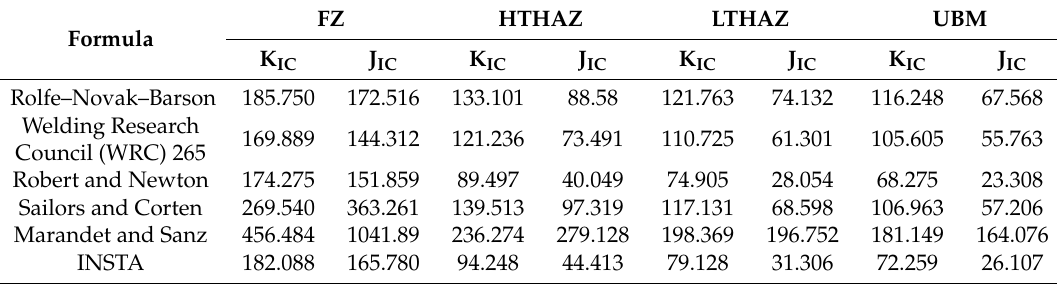
Table 6. Calculated K IC by various formulas.